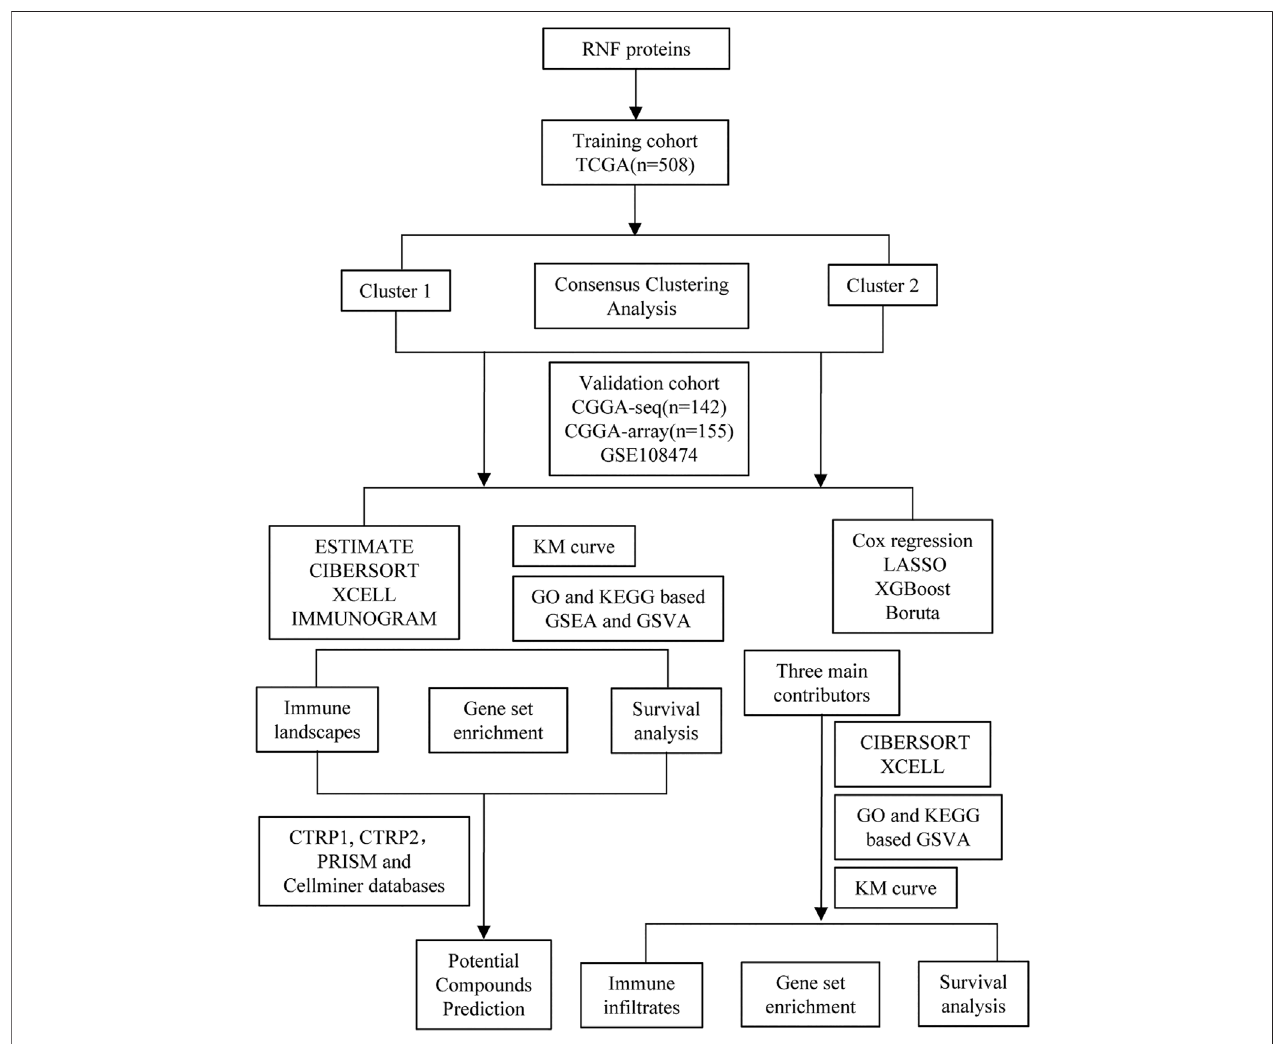
FIGURE 1 | The fl ow chart of the entire